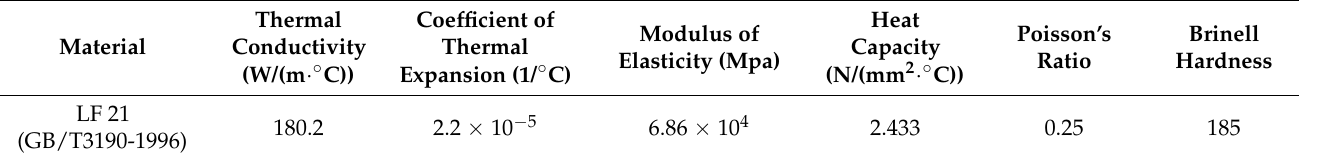
Table 3. Material parameters of the workpiece.